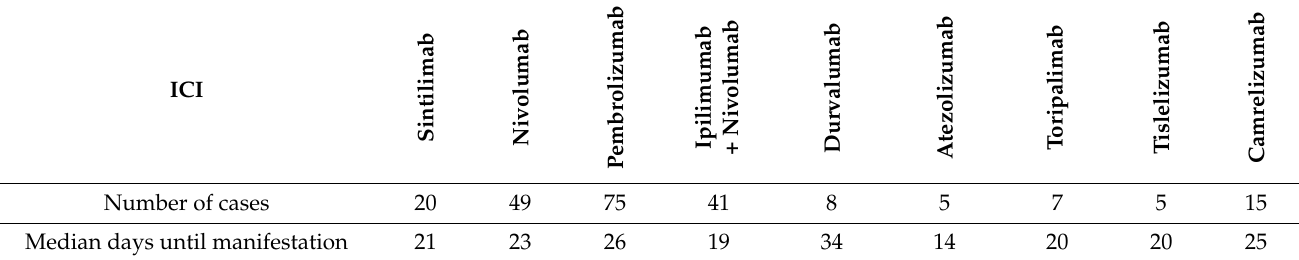
Table 4. Days until presentation of ICI-associated cardiotoxicity, organized by